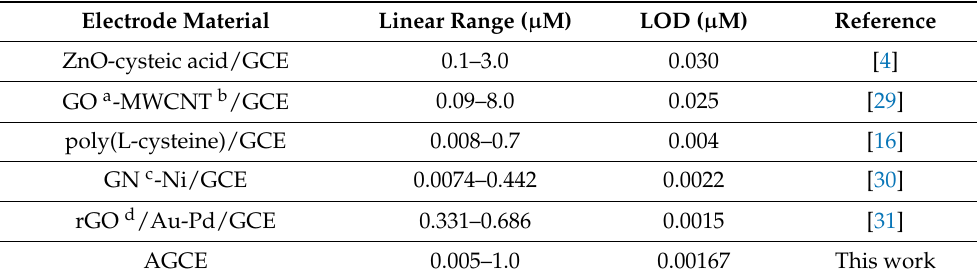
Figure 7. ( A ) SWVs response for various concentrations of SY at AGCE, ( B ) Calibration curve of SY from SWV. Table 1. Comparison with other reported electrochemical sensors for SY Table 1. Comparison with other reported electrochemical sensors for SY detection.